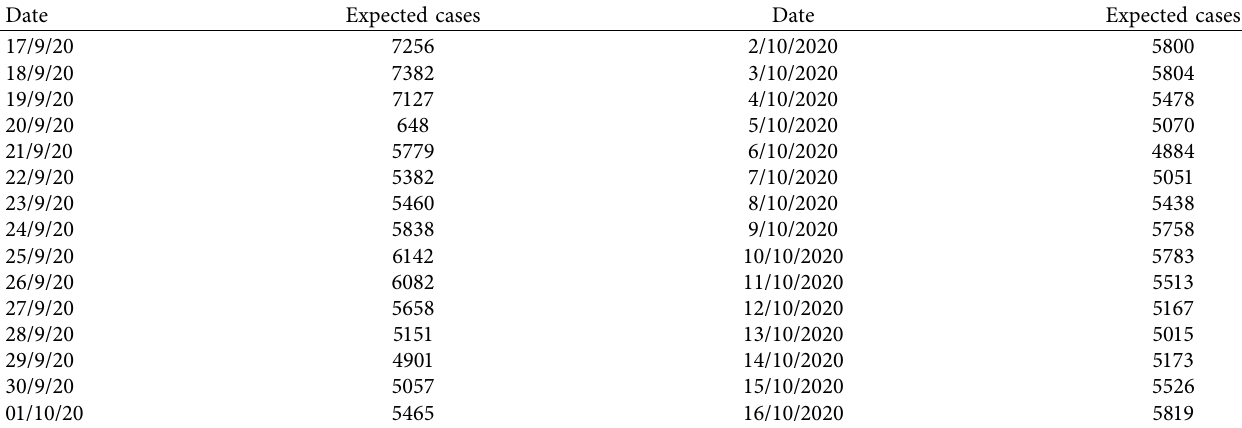
Source: own computation, 2021. Table 3: The prediction epidemic results of the new COVID-19 in Africa for the next month as predicted by the ARIMA (3, 1, 4)